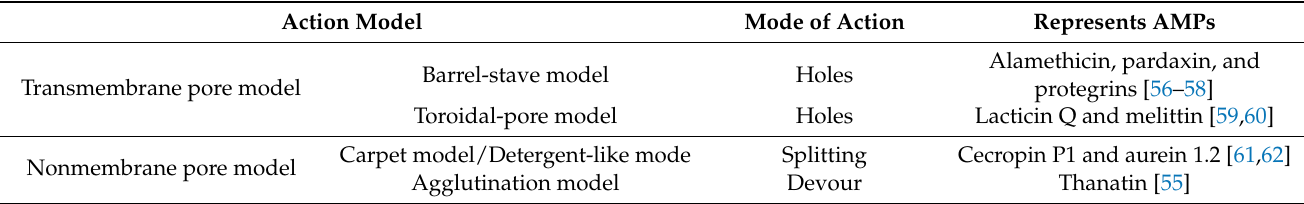
Table 1. Action model of antimicrobial peptides (AMPs) on the membrane, characteristics of each model, and typical AMPs. Action Model Mode of Action Represents AMPs Alamethicin, pardaxin, and Barrel-stave model Holes Transmembrane pore model protegrins [56–58] Toroidal-pore model Holes Lacticin Q and melittin [59,60] Carpet model/Detergent-like mode Splitting Cecropin P1 and aurein 1.2 [61,62] Nonmembrane pore model Agglutination model Devour Thanatin